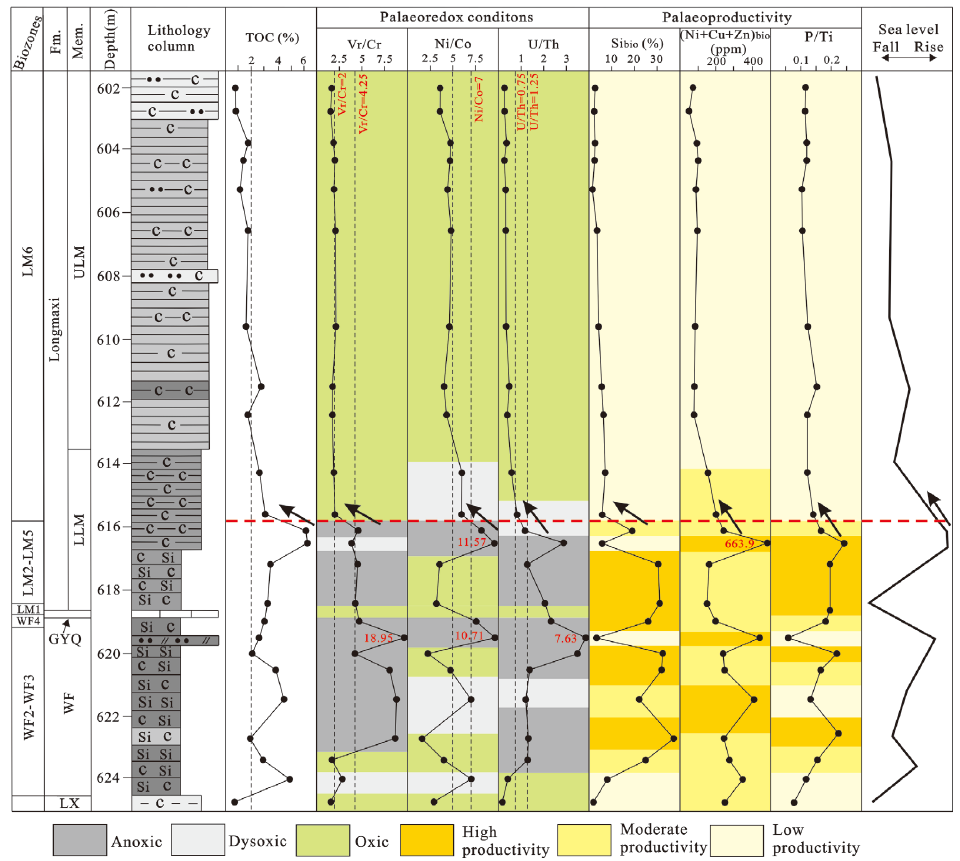
Figure 10. Vertical variations in TOC content; palaeoredox proxies V/Cr, Ni/Co, and U/Th and palaeoproductivity proxies Si bio , (Ni + Cu + Zn) bio , and P/Ti of the Wufeng – Longmaxi Formation in well YD1 showing mainly anoxic conditions and high productivity in organic - rich shales of the middle - upper WF and the lower LLM.